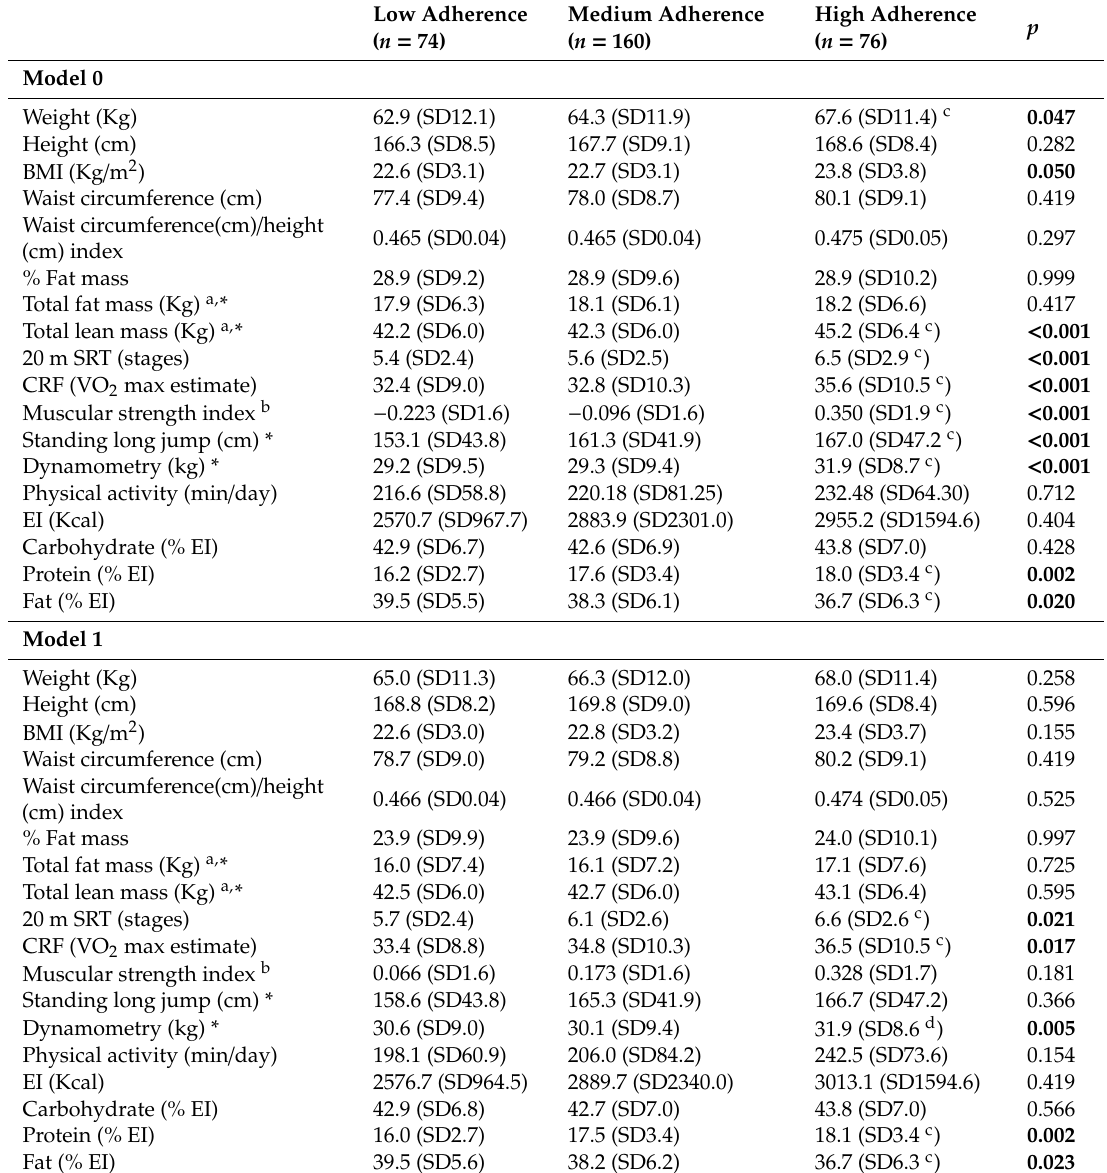
Table 3. The ANCOVA models comparing means of energy intake, body composition, and fitness parameters by MESA